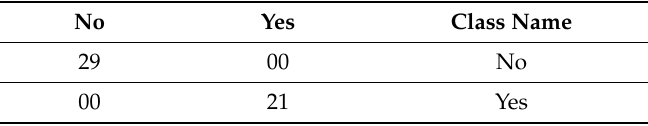
Table 23. Matrix with reduced dimensions for fold